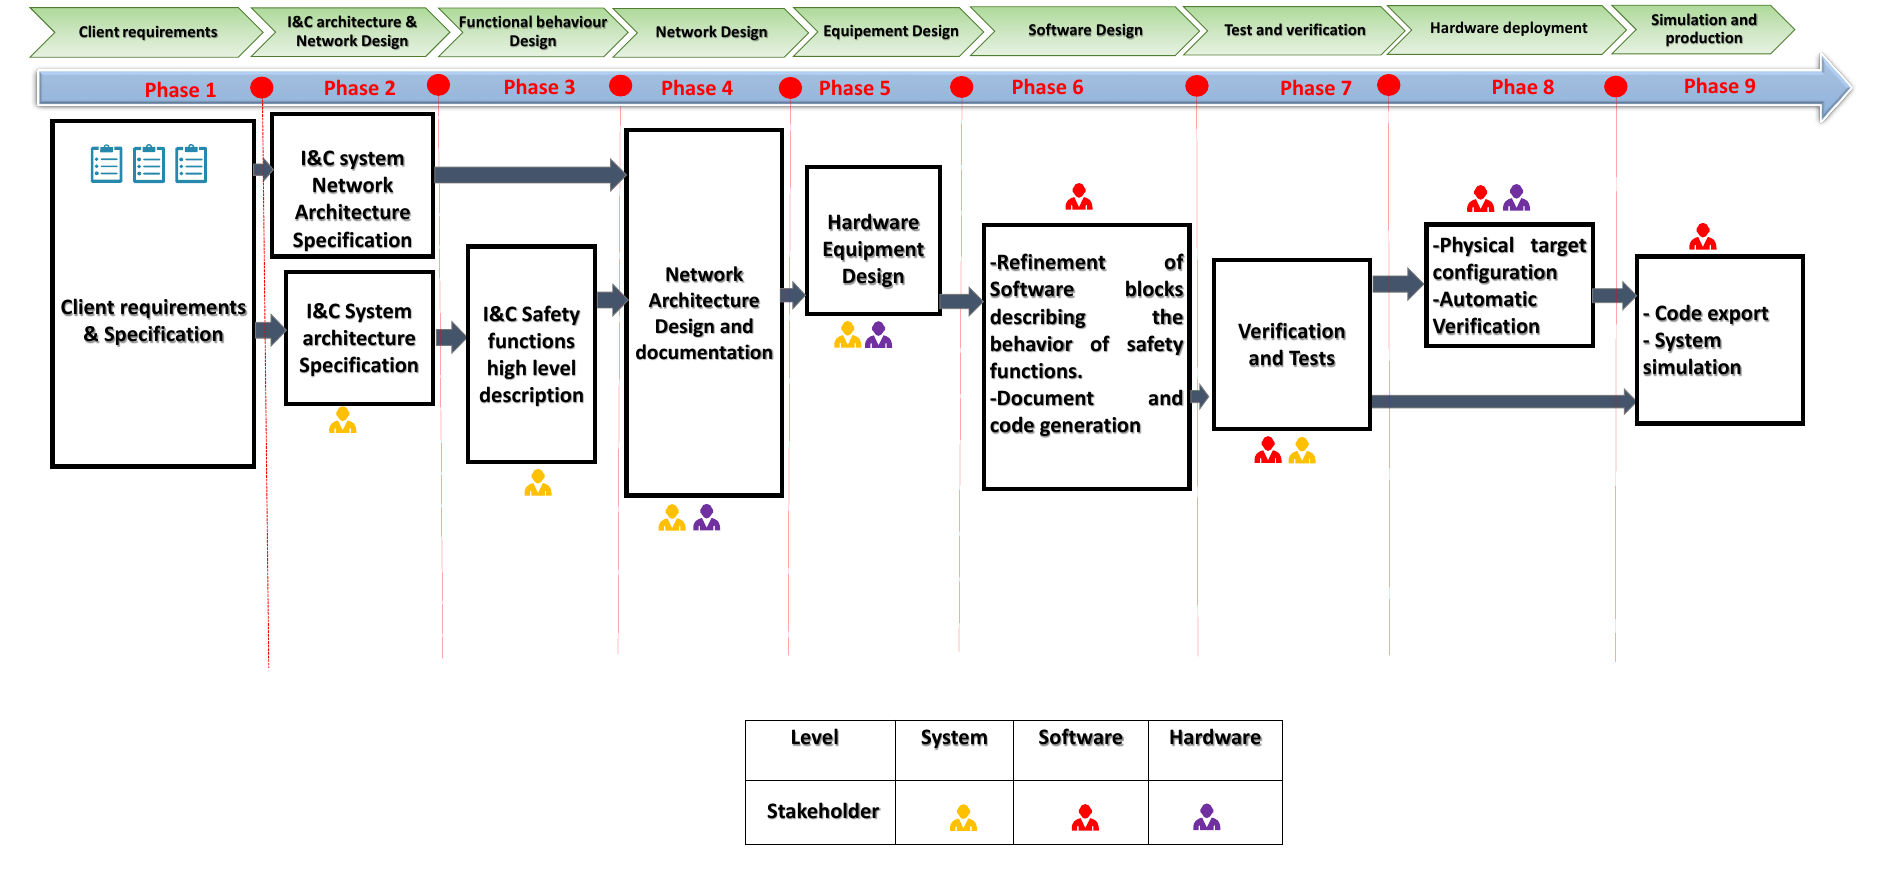
Figure 3. Methodological flow of the I&C systems development